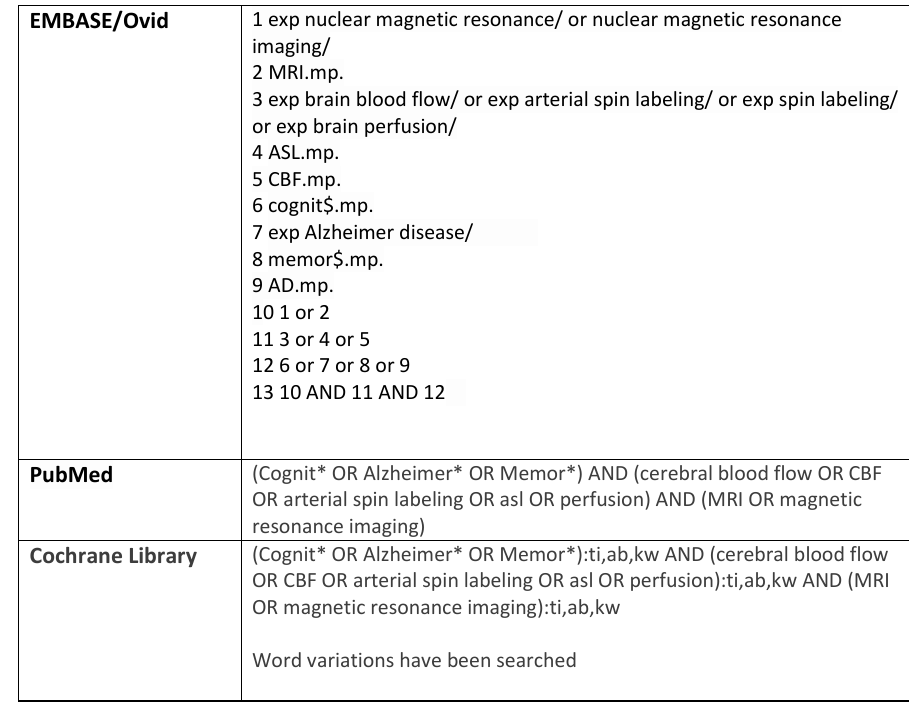
Figure A1. Full search strategy.